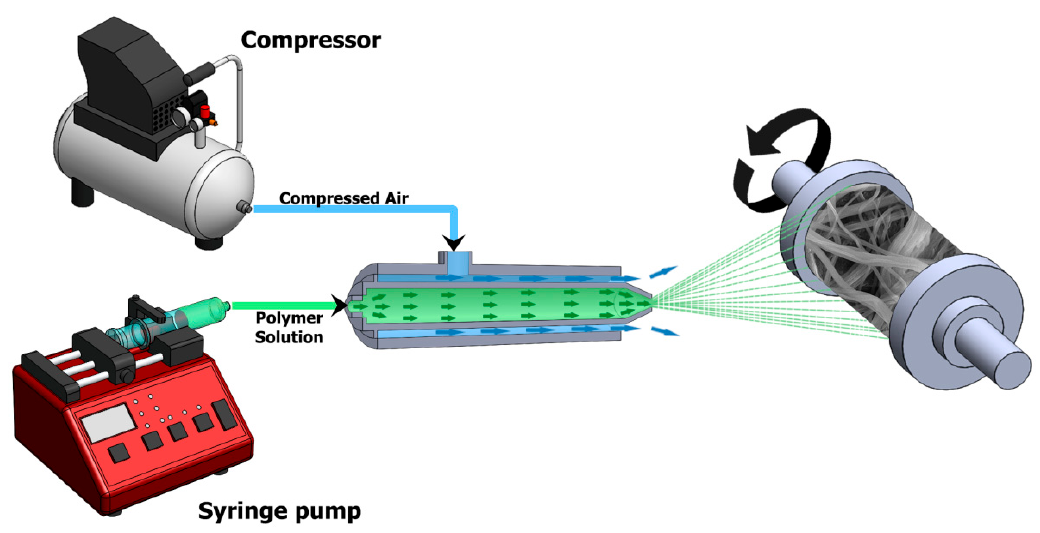
Figure 4. Schematic of solution blow spinning process.